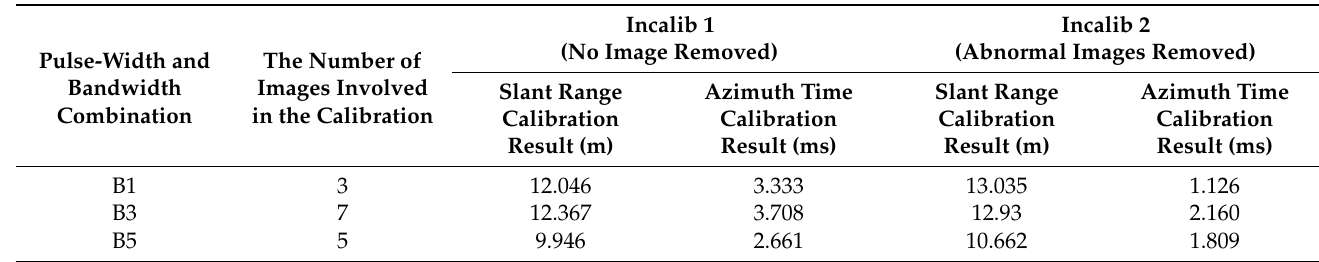
Table 4. Calibration results under different pulse-width and bandwidth combinations.